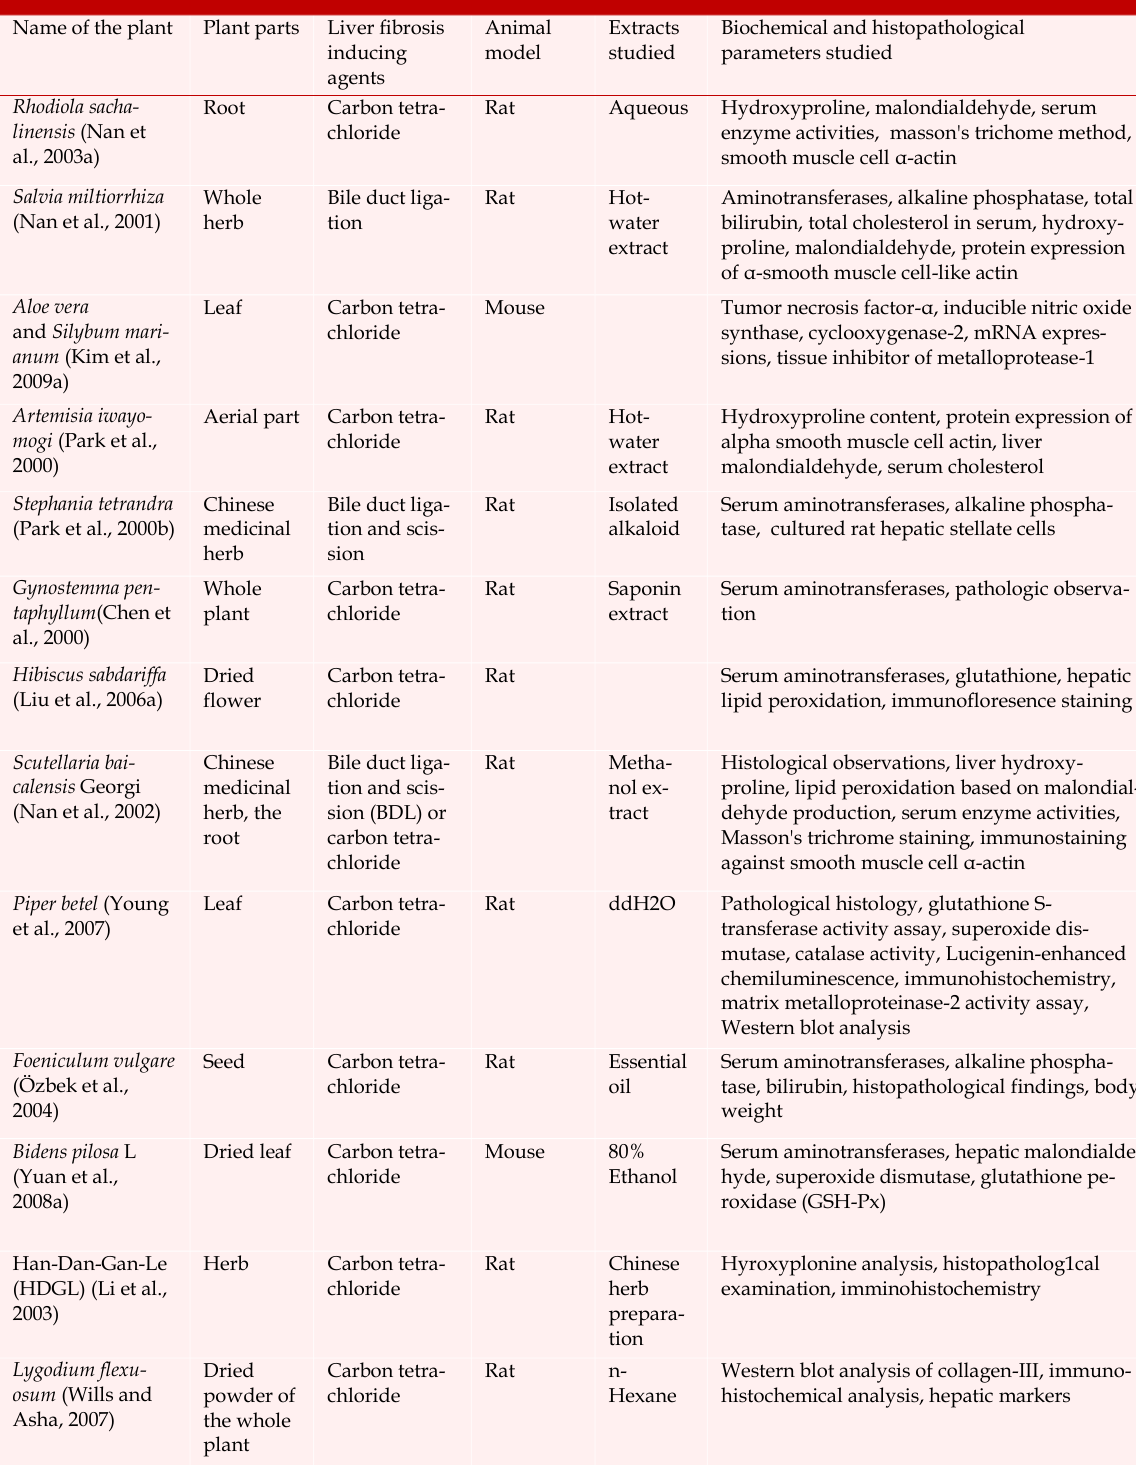
Plants used in treatment of liver